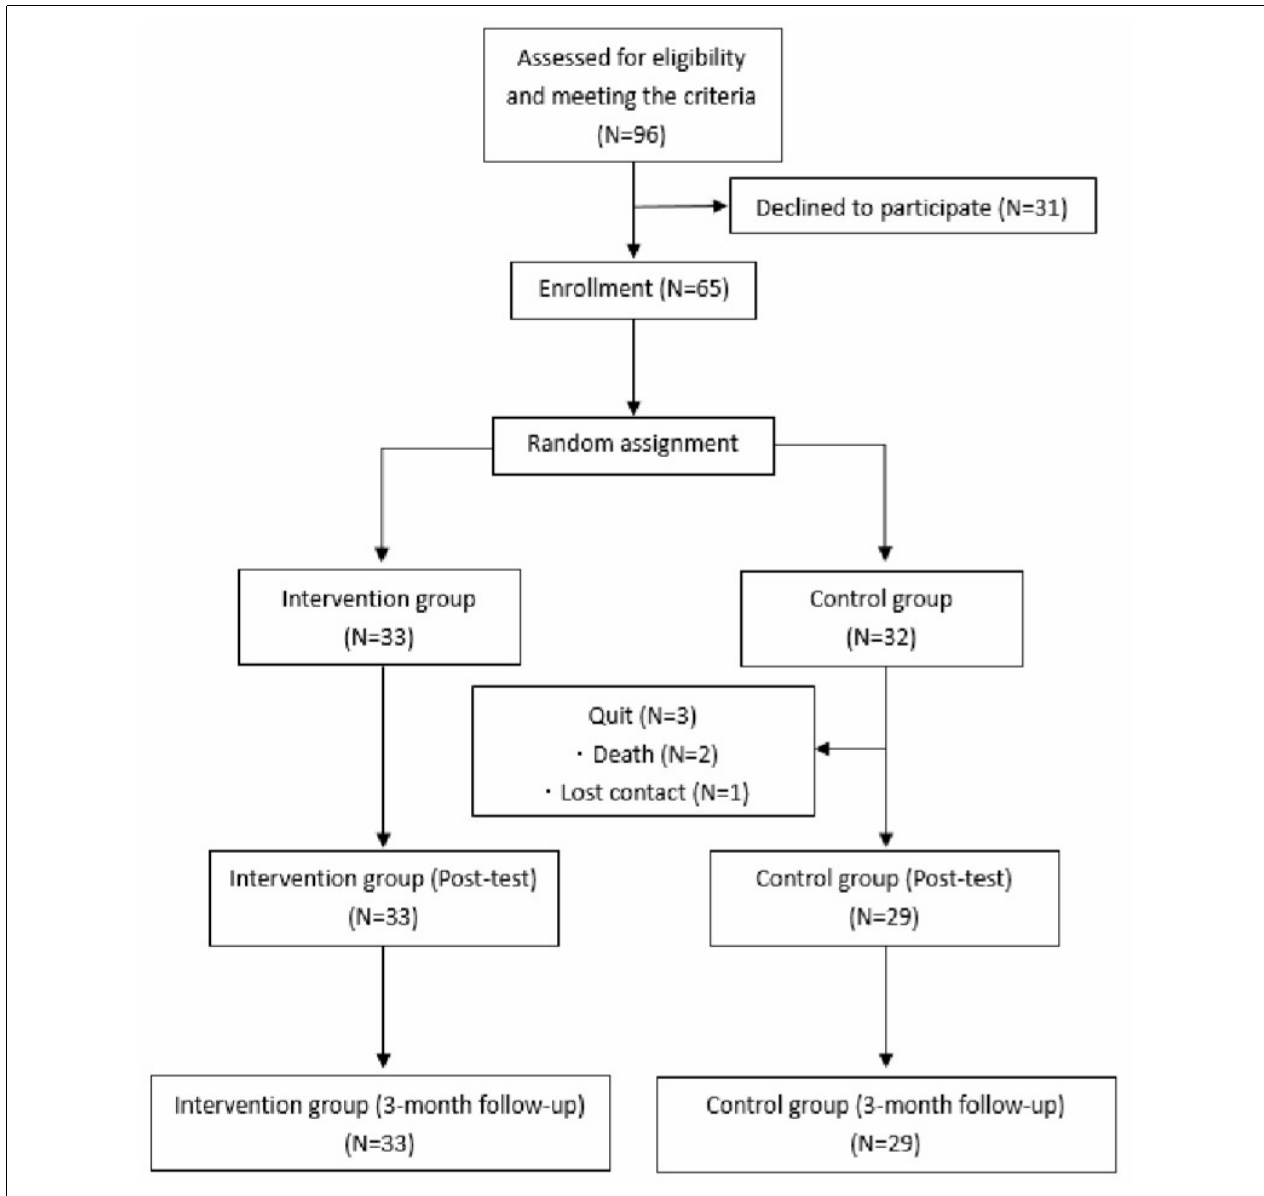
FIGURE 2 | Research